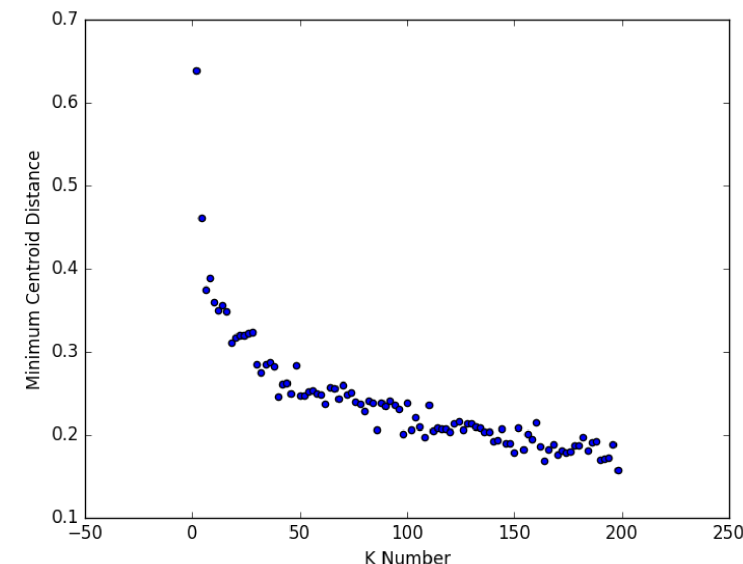
Figure 2. Selecting K for